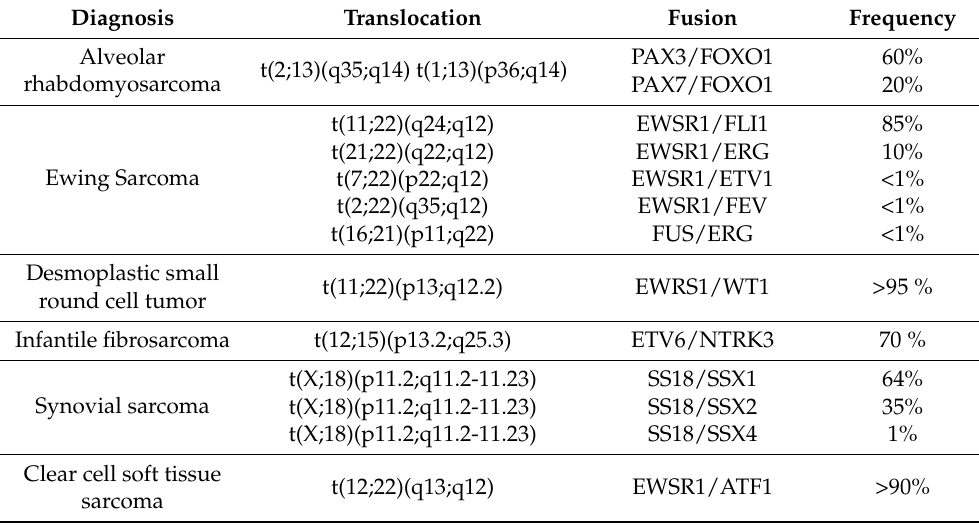
Table 1. Main fusion transcripts in paediatric sarcomas: chromosomal translocation, gene transcripts and expected frequencies. RMS: rhabdomyosarcoma; STS: soft-tissue